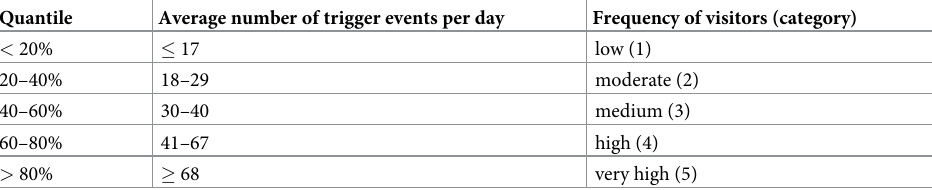
Table 2. Categorisation of visitors’ occurrence by mean daily number of light barrier triggers.